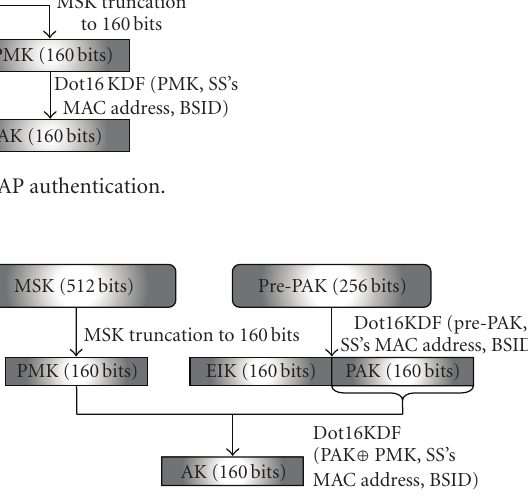
Figure 15: AK derivation with RSA-EAP